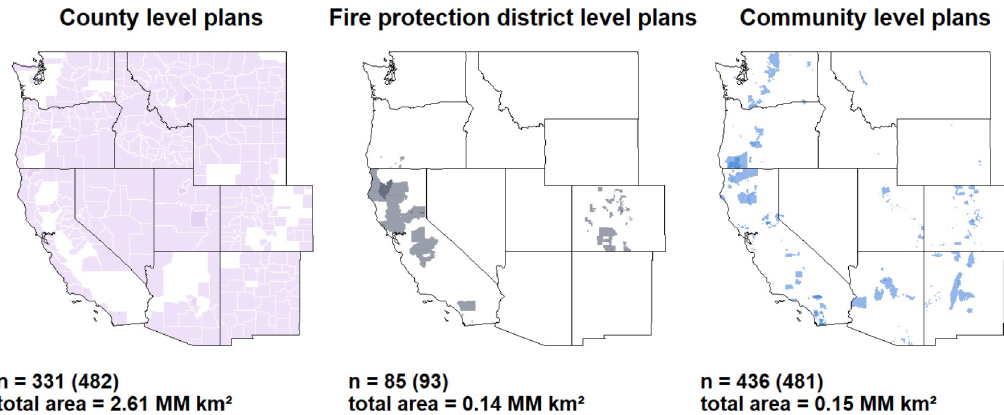
Fig 3. CWPP jurisdictions at three levels: County, fire districts, and community. Jurisdictional counts are shown below each map (with plan counts in parentheses), in addition to the jurisdictional area covered.